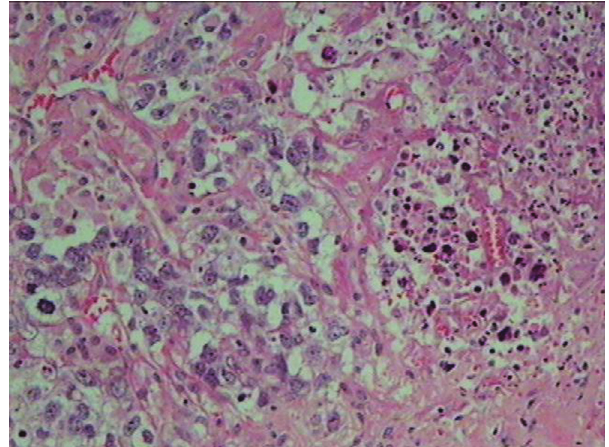
Figure 2 - Histopathological